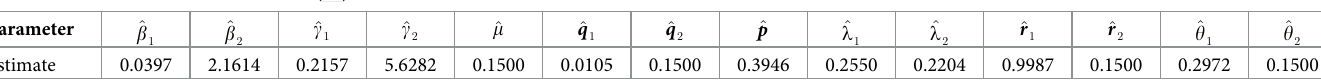
Table 5. Parameter estimates for model (35) for the Delta and Omicron variants with n = 2. Parameter Estimate